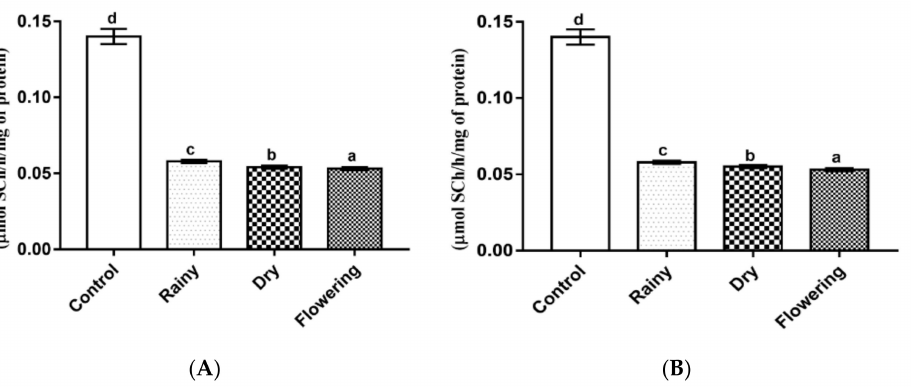
Figure 8. Biochemical changes in acetylcholinesterase of Ae . aegypti and Ae . albopictus larvae. Changes in acetylcholinesterase levels between Ae . aegypti ( A ) and Ae . albopictus ( B ) larvae treated and not treated with the essential oils of Lippia grata . Different lowercase letters in the bar denote significant difference ( p < 0.05). Bars represent standard deviations ( n = 3). Values estimated by one-way ANOVA followed by the Tukey test. Control, untreated